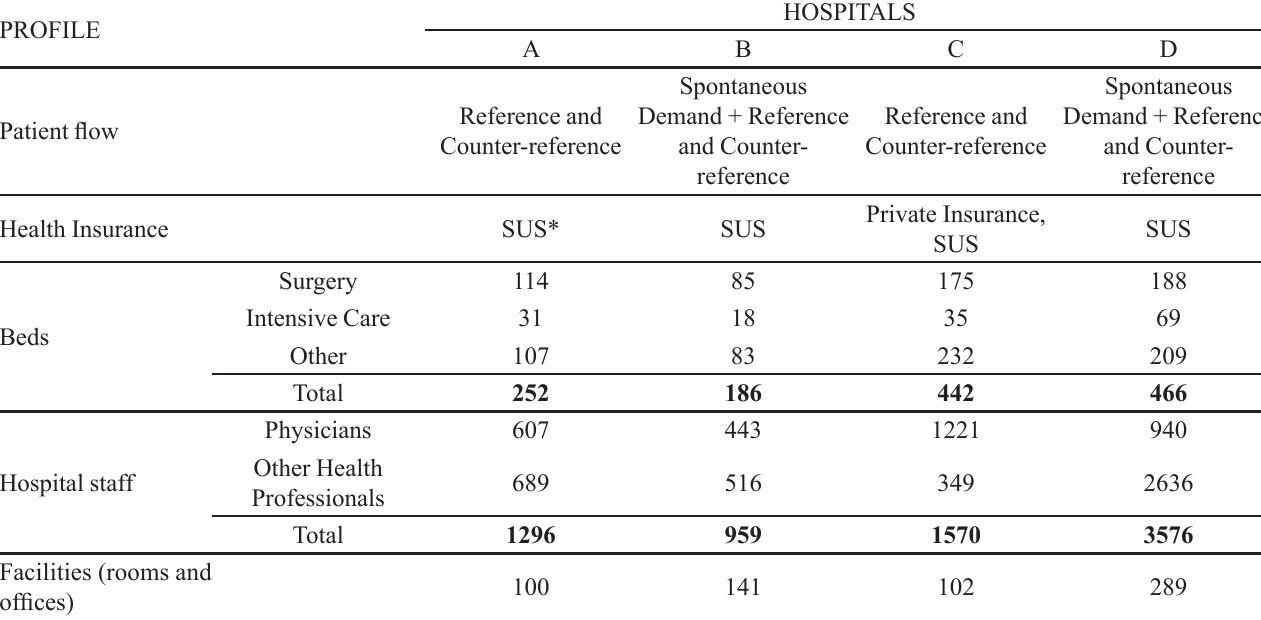
TABLE I - Care profile of large, highly complex university hospitals. State of Rio de Janeiro, 2011